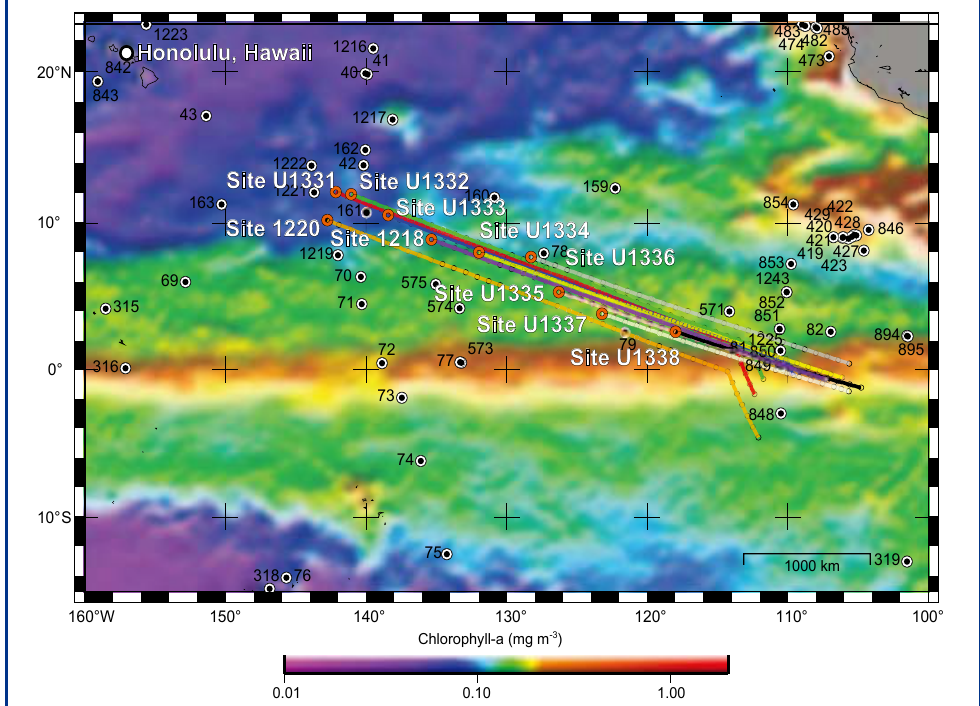
Figure 1B. Backtracked positions for PEAT sites (open red circles) , using stage poles from Koppers et al. (2001) superimposed on a satellite-derived (GlobColour) map of present ocean chlorophyll-a concentrations (December 2005 monthly mean) where red = high productivity and blue = low productivity. Solid black circles = previous DSDP and ODP